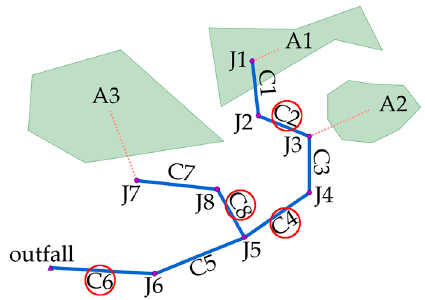
Figure 3. Example for the definition of potential measurement locations (encircled conduit names). Designations: Area, Conduit, Junction.